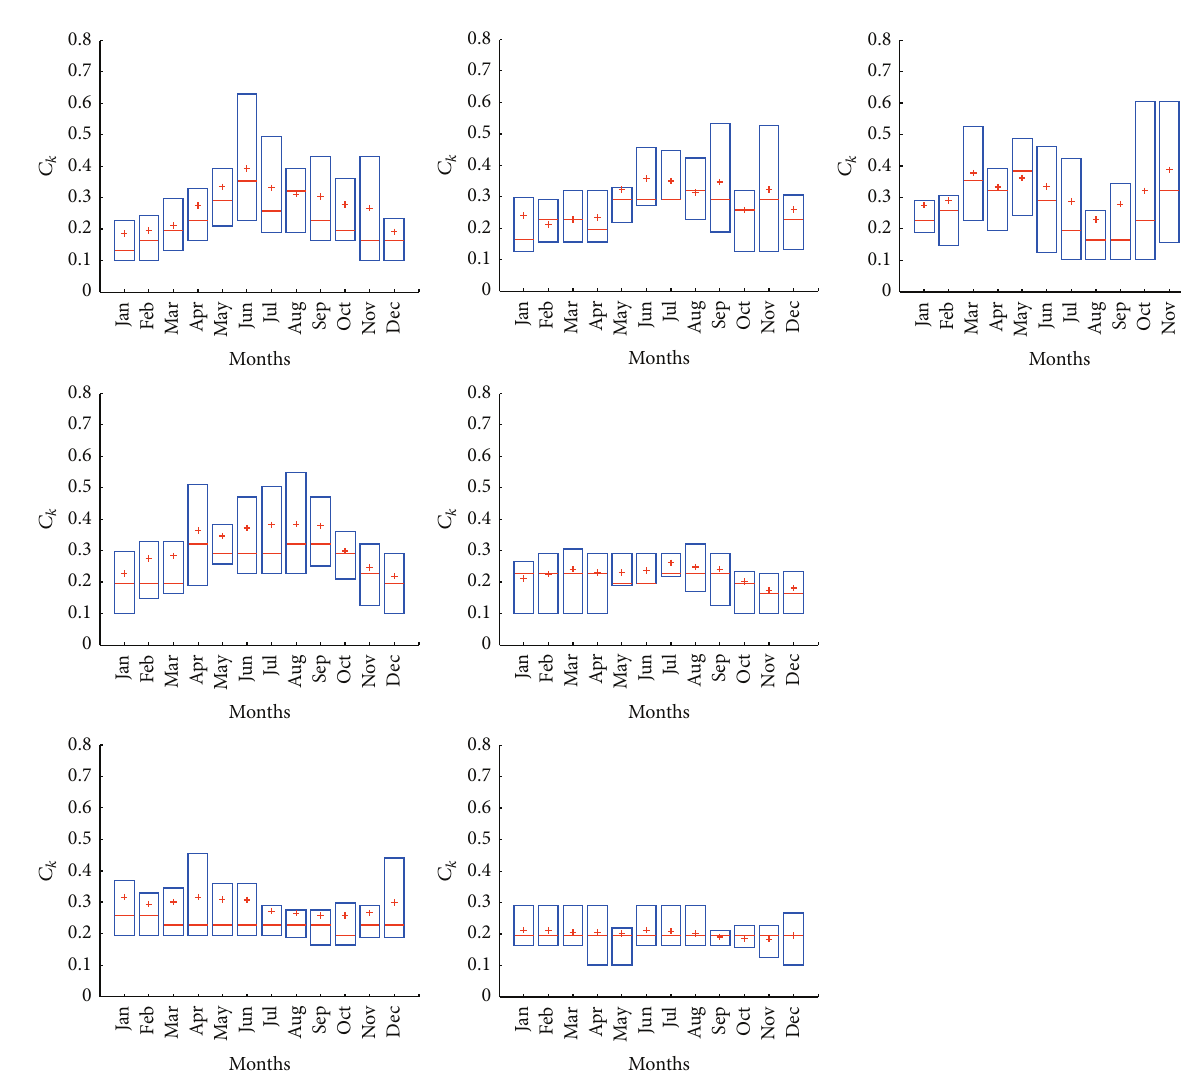
Figure 6: Seasonal variation of parameter 𝐶 𝑘 based on the DYNIA for the RMSE (left column), TRMSE (central column), and ROCE (right column) OFs and for 3 (top), 7 (middle), and 13 (bottom) months.